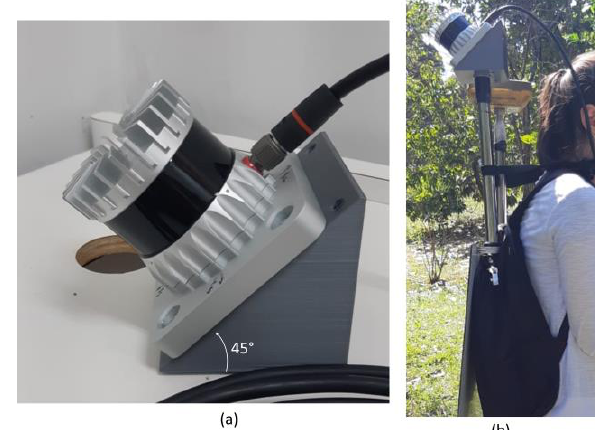
Figure 5. MLS (a) OS0-128 laser scanning system with 45° inclination and (b) the backpack platform used to acquire the data.